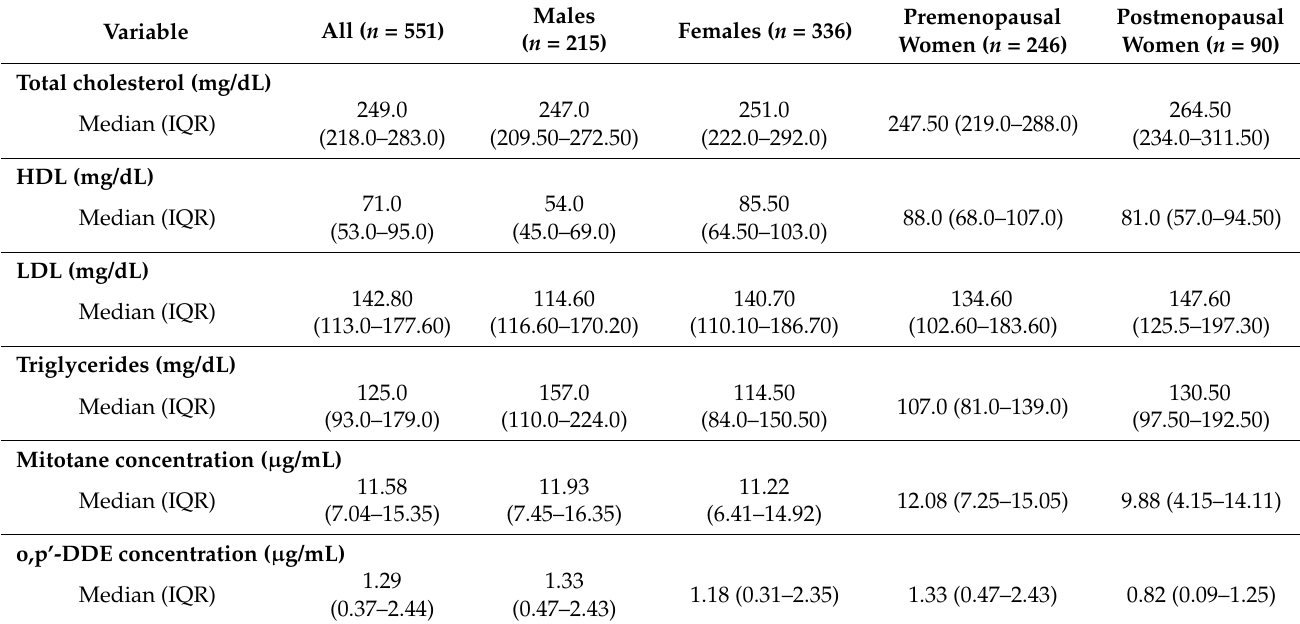
Table 2. Lipid levels and pharmacokinetic data of the 551